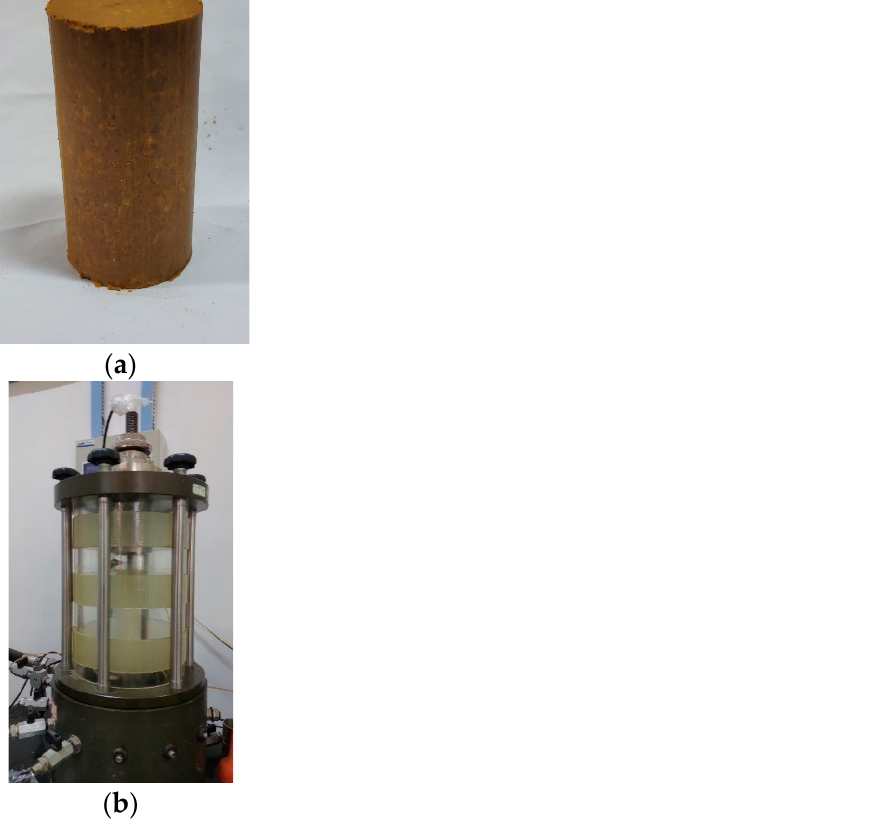
Figure 4. Dynamic triaxial test of silty clay. ( a ) Silty clay specimen. ( b ) GDS dynamic triaxial test system.